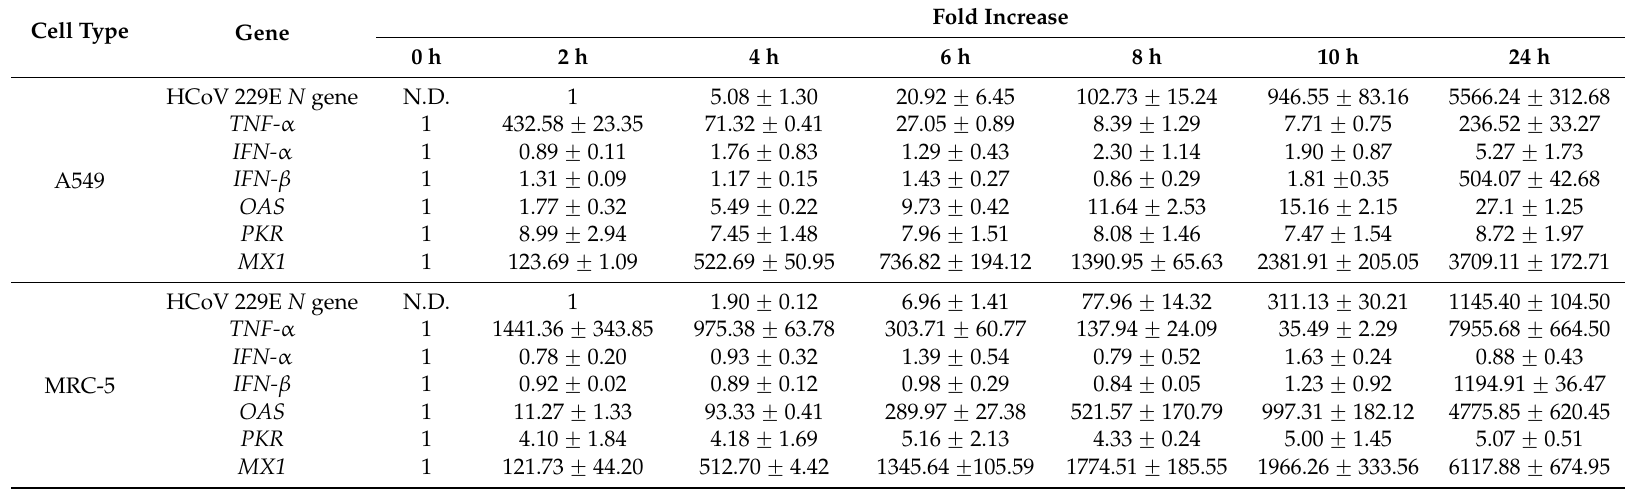
Table 1. Time course pattern of antiviral gene expression in the A549 and MRC-5 cells upon HCoV 229E